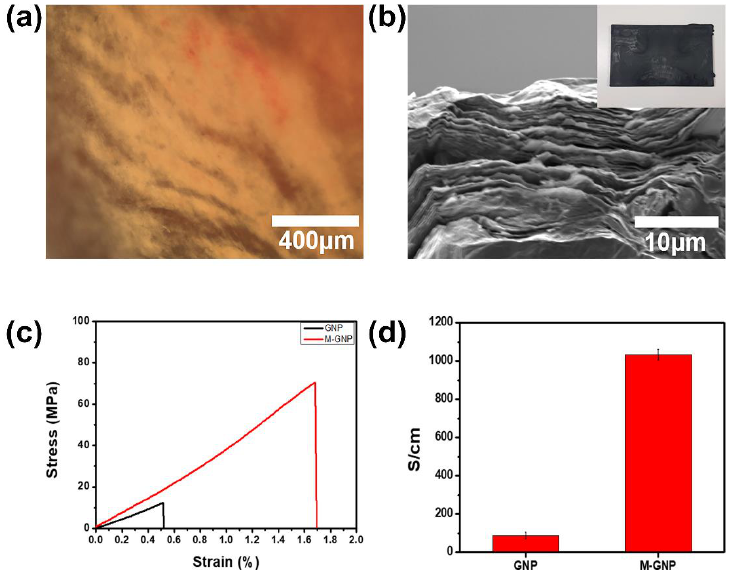
Figure 2. Microstructure and properties of M-GNP electrodes. ( a ) Polarized optical microscopy (POM) image of 20 mg/mL of M-GNP. ( b ) SEM image and photograph of M-GNP electrode (5 cm